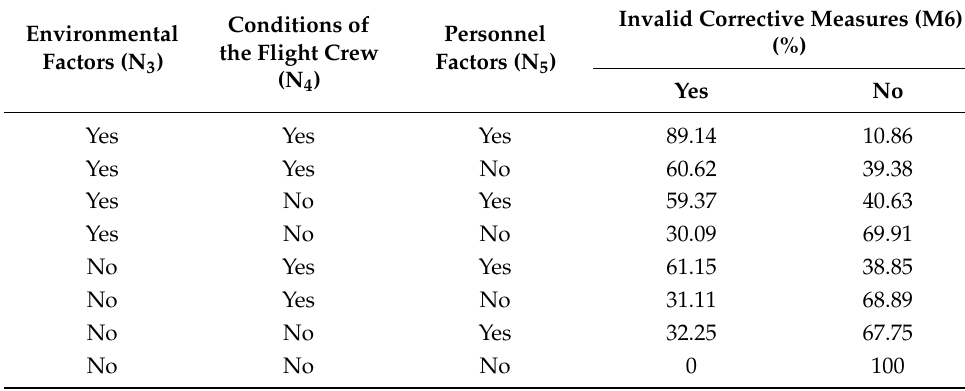
Table 5. The prior probabilities of the root